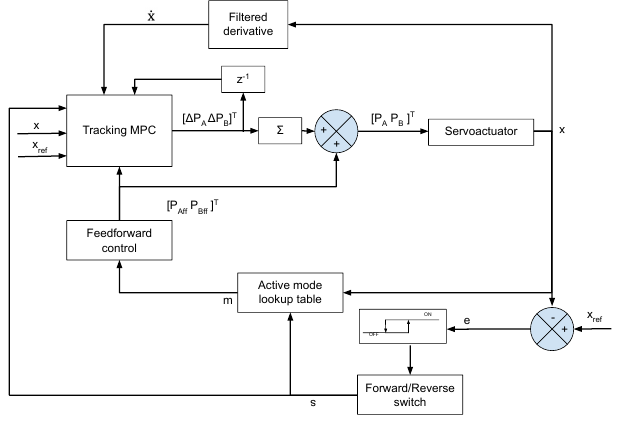
Figure 9. Overall SMPC system. Table 3. Feedforward control lookup